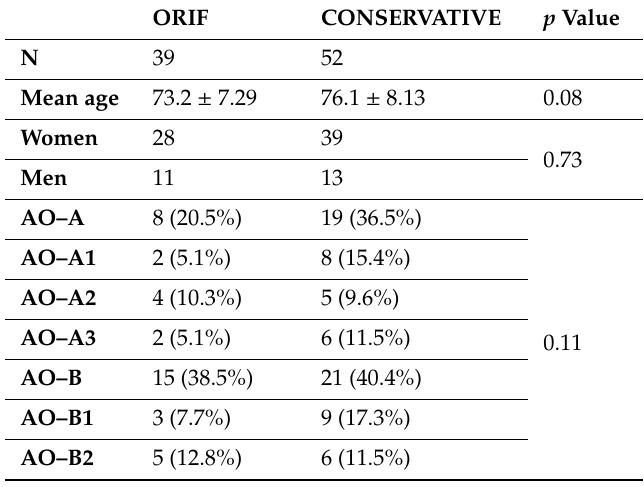
Table 1. Demographics. AO = AO classification principles; “A” = extra-articular; “B” = partially articular; “C” =